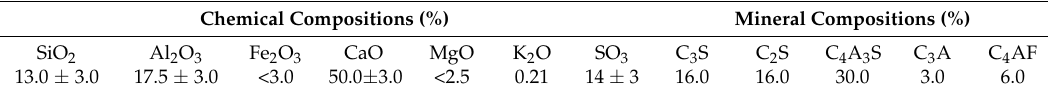
Table 1. Chemical and mineral compositions of rapid-hardening cement.